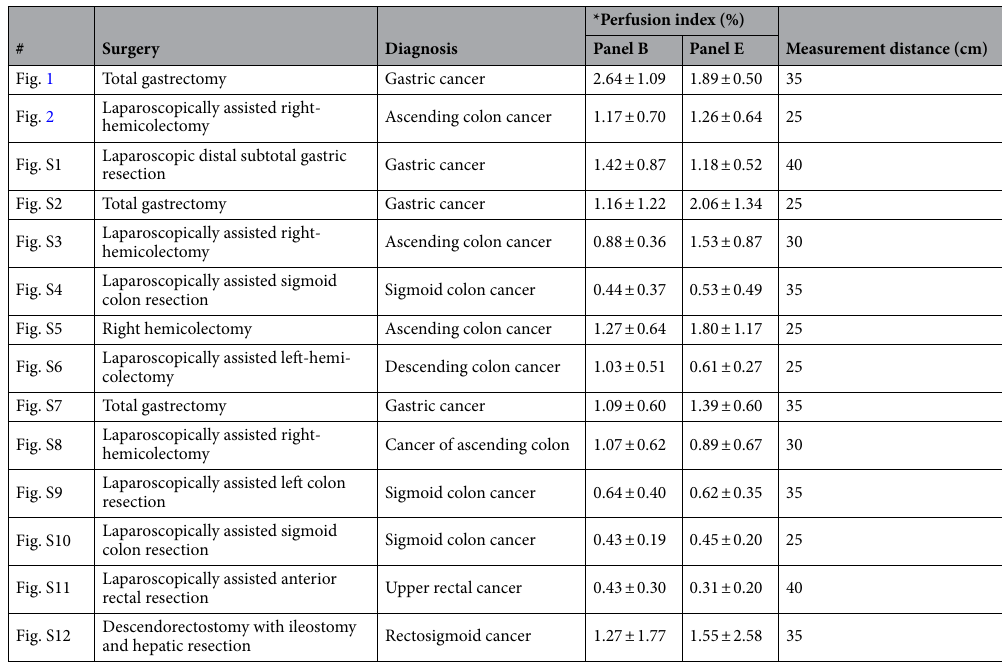
tion involved dividing the proximal part of the jejunum into two loops that formed the letter Y (Roux-en-Y reconstruction). One part (proximal) of the jejunum draining the biliary tract and pancreas was designated as a biliopancreatic loop while the other part (anastomosed with the esophagus) as the alimentary loop. Before the jejunum was cut 20 cm from Tretz’s ligament, the mesentery was transected in this zone with ligation and cross- ing of the second jejunal branch in order to sufficiently mobilize the future alimentary loop. Moreover, to create an optimal space for using the stapler, additional devascularization of a jejunum segment was performed. As a result of these surgical procedures, a segment of the jejunum was formed with a difference in perfusion from complete cessation of blood supply to normal blood supply. At this stage, the surgeon identified several zones with different perfusion by placing three marks. A color photograph of the jejunum prepared for anastomosis is shown in Fig. 1A. The surgeon’s markings are shown in the enlarged view of the jejunum (Fig. 1B) as M1, M2, and M3. According to the surgeon, perfusion below M3 is good, M2 marks the center of the region with inter- mediate perfusion, whereas the area above M1 is not perfused. The surgeon’s prognosis was compared with spatial distribution of the APC parameter assessed by the iPPG system. APC map in Fig. 1B is overlaid with the enlarged image of the jejunum. It is coded in pseudo colors with the scale shown on the right: red for more perfusion and blue for less. As seen in Fig. 1B, perfusion is higher in the lower jejunum, consistent with the surgeon’s prognosis. To quantify the change in perfusion index along the jejunum, we estimated the mean APC in several large ROIs of 60 × 60 pixels. The assessment showed that the maximum perfusion index (100%) is observed around the yellow circle, then decreasing to 58% near the M1 mark, to 37% near M2, and to 12% near M3. Moreover, PPG pulses (see details of their calculations in the subsec- tion “Data Processing”) in the lower part displays poor synchronization with ECG (shown in the panel D, graph D4 in Fig. 1) that is usually observed with impaired circulation. In contrast, there is reasonable synchronization of ECG and PPG waveform in the upper part of the jejunum as illustrated in the graph C4, panel C in Fig. 1). The parameters of blood supply to the jejunum, measured with iPPG, confirmed the judgment of the surgeon, who decided to perform a resection near the M3 marker along the red dashed line. The formation of the interintestinal Roux-en-Y anastomosis was carried out according to the "end-to-side" type: by suturing the end of the biliopancreatic loop into the side of the continuation of the alimentary loop. It was done manually using a two-row continuous stitch with PDS 3-0 suture. After the anastomosis has been performed, the tissue blood supply to the connected organs was assessed again by the iPPG system. Color pho- tograph of a general view of the connected intestines is shown in Fig. 1F. The spatial distribution of the APC perfusion index overlaid with an enlarged image of the anastomosis is shown in Fig. 1E. As seen, the perfusion index is much more evenly distributed over both connected organs. Additionally, the mean PPG pulses are well synchronized over almost the entire surface of both intestines, as shown by the examples of calculating these pulses 40 × 40 μm 2 regions located in the centers of the red and cyan squares (see graphs G4 and H4 in Fig. 1G,H, respectively). Mean PPG pulse shown in Fig. 1G can be considered as a reference, since there were no factors compromising blood supply in this part of the jejunum. The area for measuring the perfusion in the biliopan- creatic loop after the anastomosis formation (Fig. 1H) corresponds to the area in which perfusion was estimated